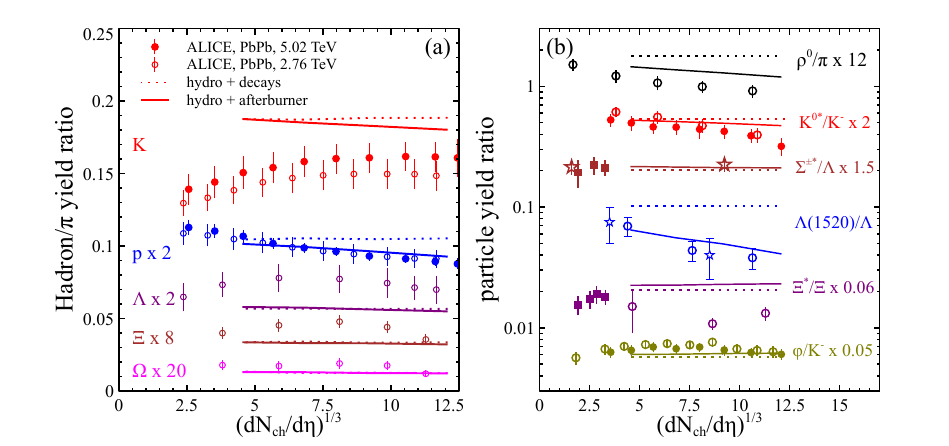
Figure 1. Midrapidity yield ratios of stable hadrons (a) and selected resonances (b) in pPb, PbPb, and AuAu collision. Ratios are shown as a function of a charged particle multiplicity per unit of pseudora- pidity, dN ch / d η , at η = 0. Dotted lines correspond to hydrodynamics simulation and resonance decays, full lines stand for the simulation with account of hadronic rescattering after hydrodynamical stage. The results of simulations are compared to experimental data from PbPb collisions at 5.02 TeV (full circles) [24, 25], PbPb collisions at 2.76 TeV (open circles) [16–18, 26–29], pPb collisions at 5.02 TeV (squares) [19], and AuAu collisions at 200 GeV (stars)